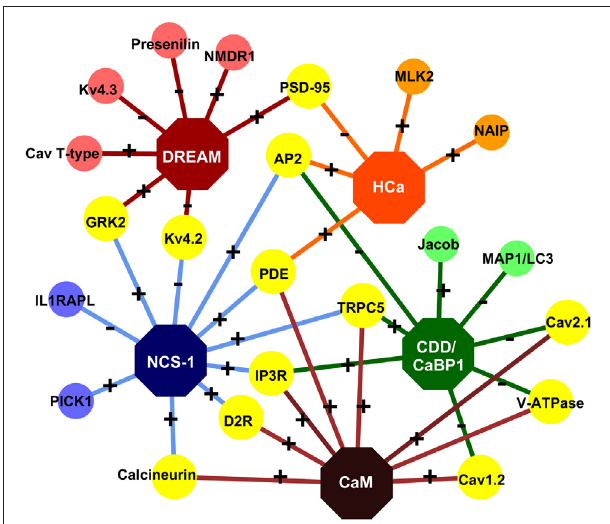
FIGURE 2 | The NCS/nCaBP interactome. Some of the known targets of the NCS and nCaBP family members in the spine are shown. Specific interaction partners are color-coded according to the color of the sensor. Common interaction partners are shown in yellow. “ + ” and “ − “ indicate Ca 2 + -dependence and -independence of an interaction, respectively. AP2: Clathrin adaptor protein 2 [Haynes et al. (2006)]; Calcineurin [Schaad et al. (1996); Xia and Storm (2005)]; Cav1.2: Voltage-gated (L-type) Ca 2 + channel [Zhou et al. (2004), (2005); Tippens and Lee (2007); Dick et al.